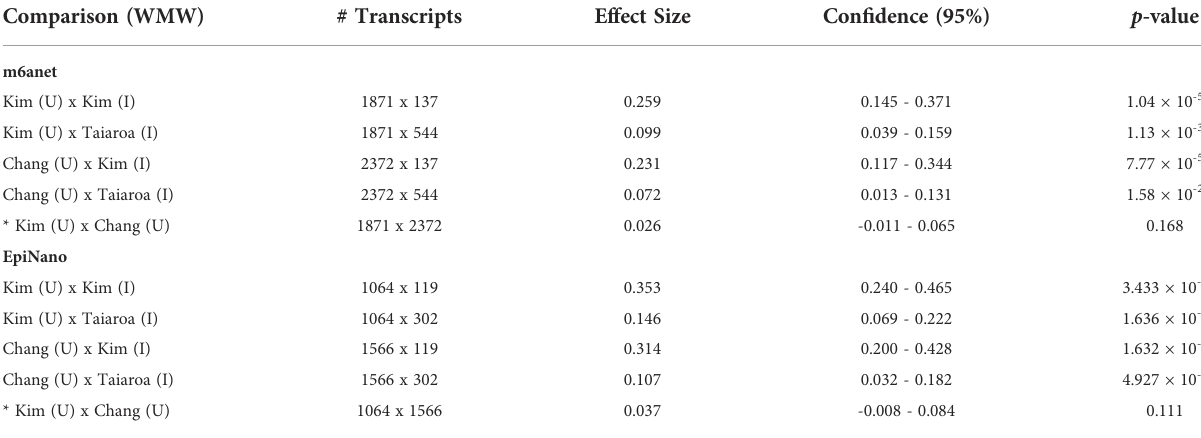
(*) Comparison between twoUninfected Vero celldatasets. Datasets are as indicated inTable 1, being Kim (Kim et al.,2020), Taiaroa (Taiaroa et al.,2020) and Chang(Changet al.,